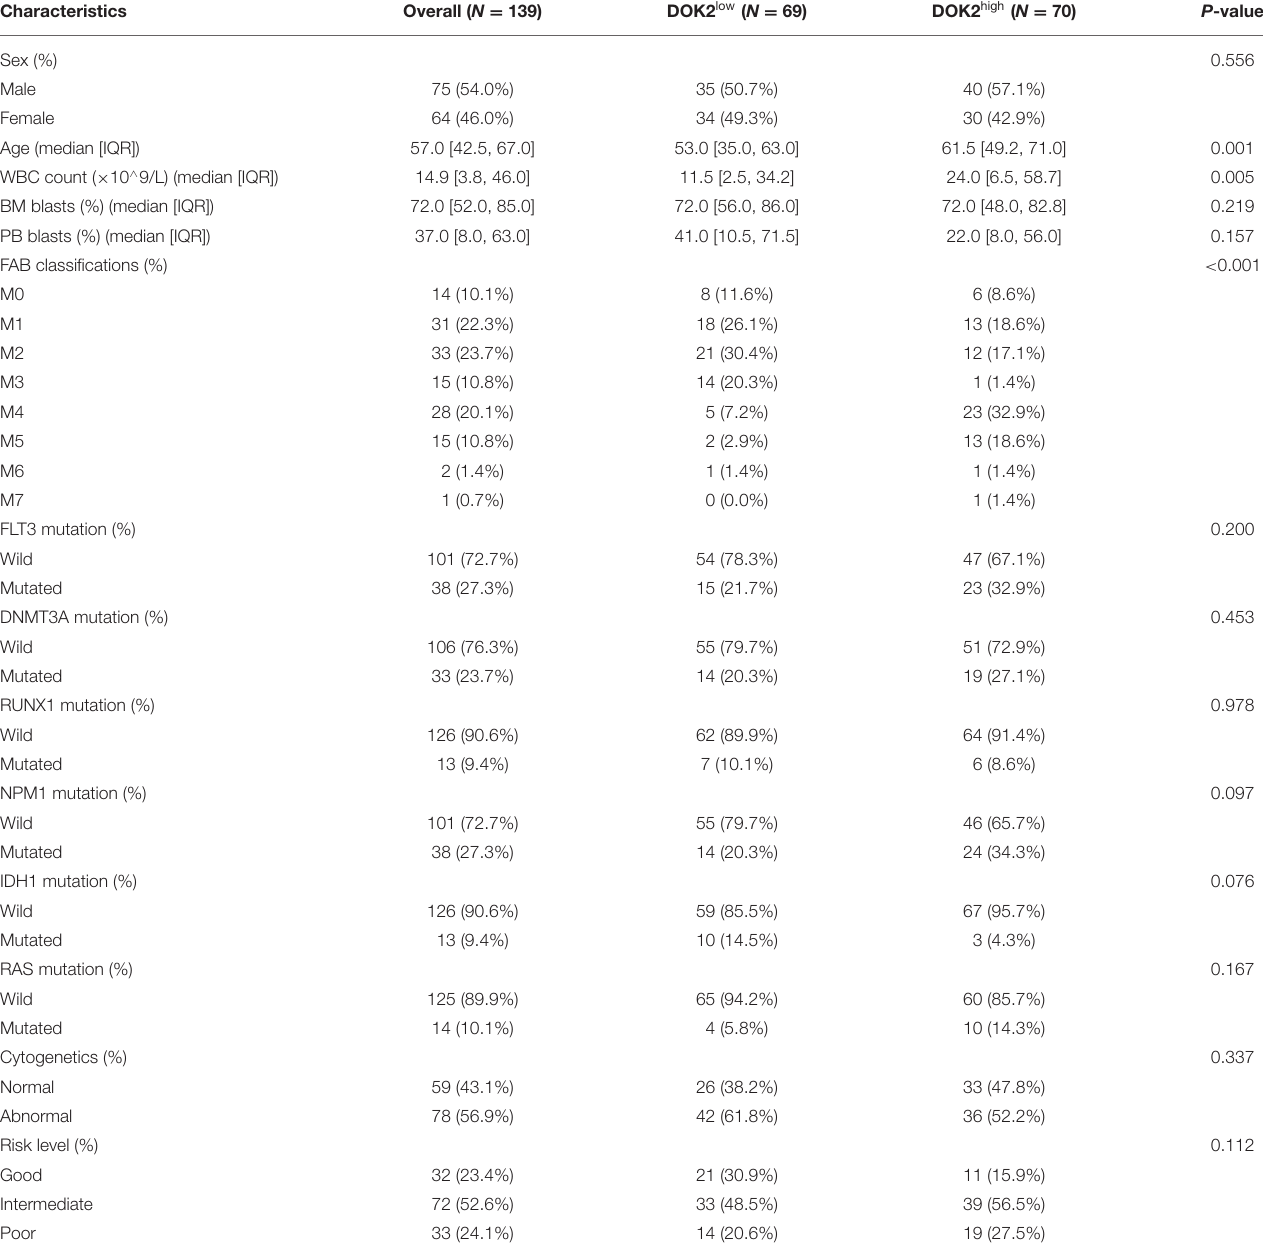
TABLE 1 | Clinicopathological features of AML patients in the TCGA cohort.